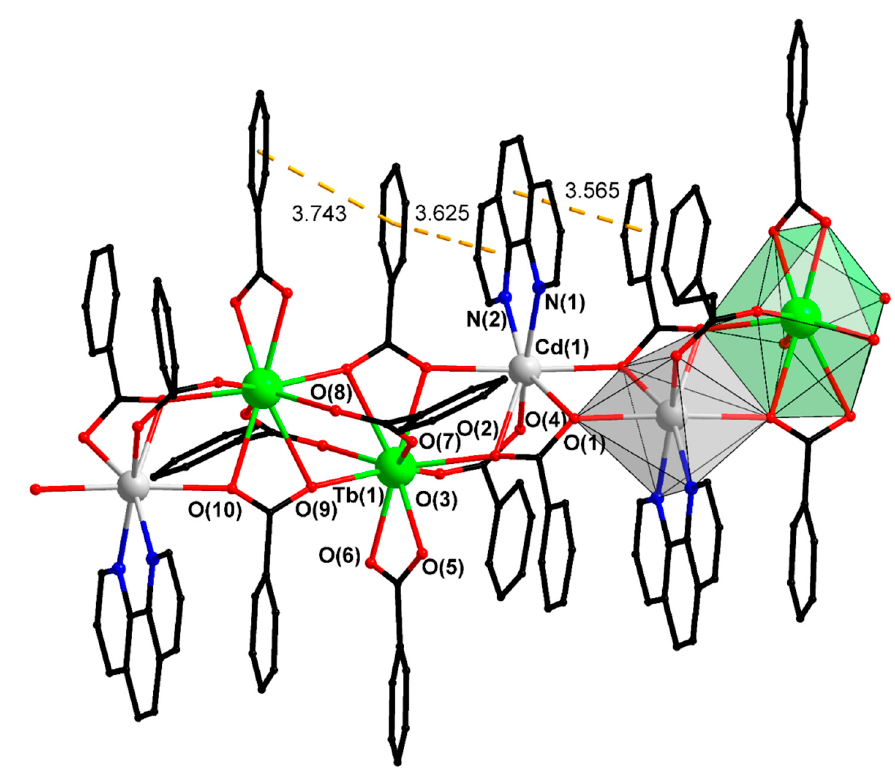
Figure 1. A fragment of polymeric chain of III. Hydrogen and fluorine atoms are omitted (dotted lines.